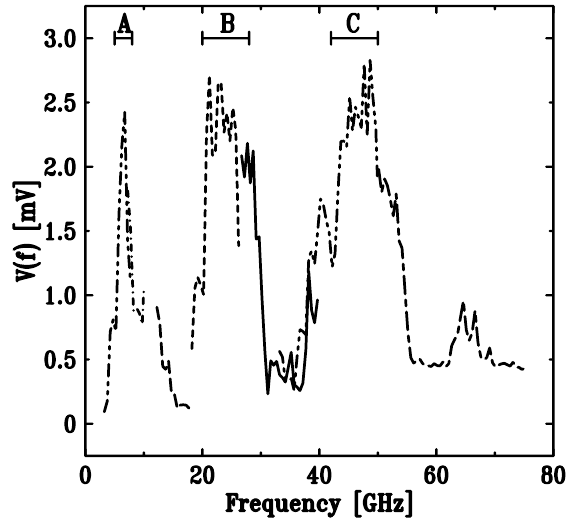
bunch.FIG. 2. The measured microwave spectrum for I > I Different line dashing is used for each of the waveguide bands. The peaks labeled A, B, and C are described in the